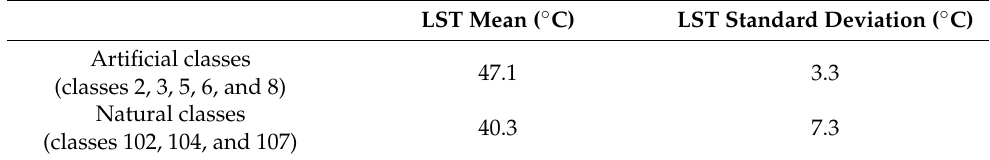
Table 4. LST statistics for artificial and natural classes.